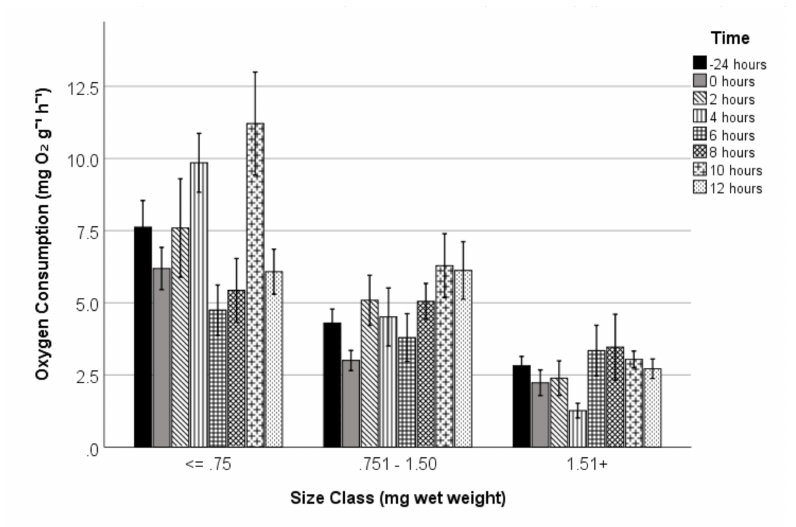
Figure 2. Mean mass-specific respiration rates (MO 2 (mg O 2 g − 1 h − 1 )) (mean ± 1 one se) over the 12 h period of recovery from 24 h of moderate hypoxia (20% air saturation). Respiration was measured for all subjects at a normoxic reference ( − 24 h), after 24 h of hypoxia (0 h), and at six 2h normoxic recovery intervals (2, 4, 6, 8, 10, and 12